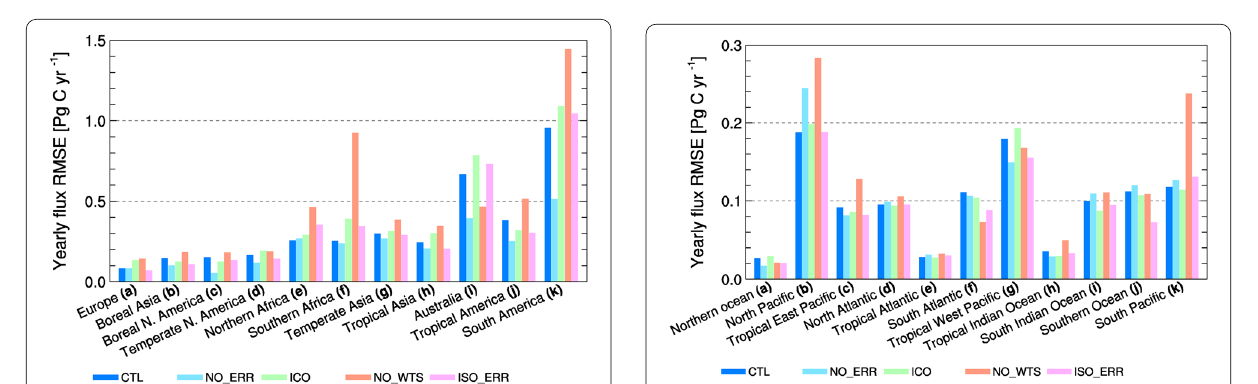
mole fractions consistent with the observations. Such flux compensations could occur where observations are sparse, which may lead to further errors in flux estimates.